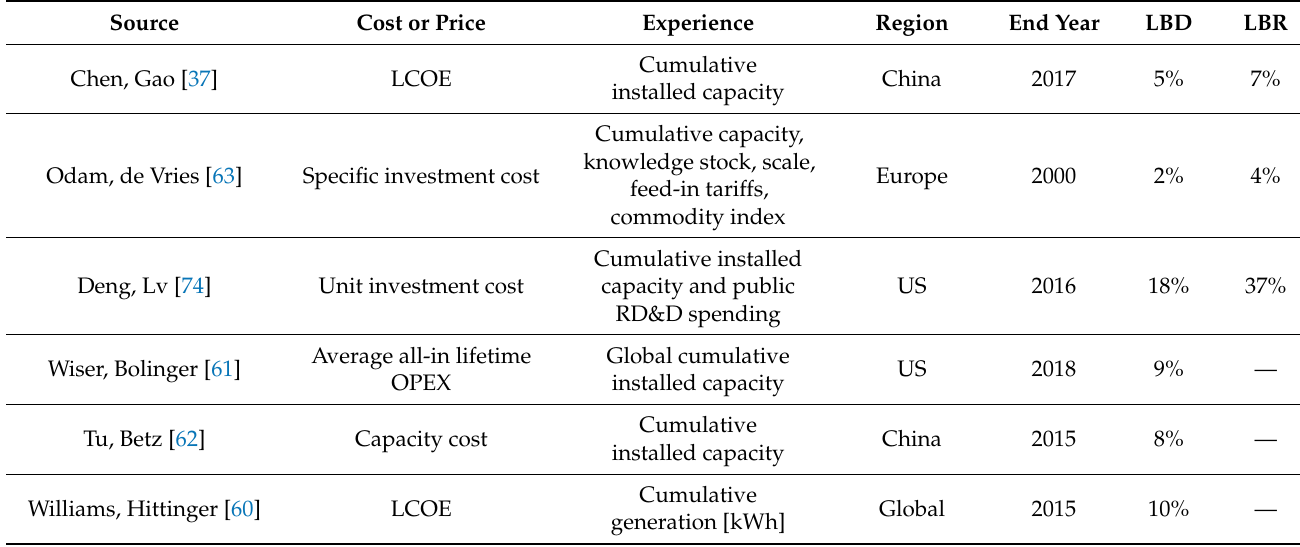
Table A2. Recent studies that report LRs for wind